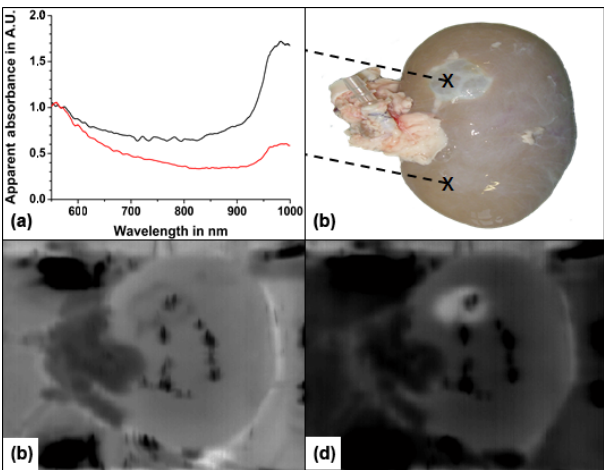
Figure 5. Kidney with a cyst, shown as RGB image (b) , absorption image at 600nm (c) and at 970nm (d) . The corresponding spec- trum shows the spectral differences between the region with the cyst (black line) and tissue with no abnormalities (red line), (a)